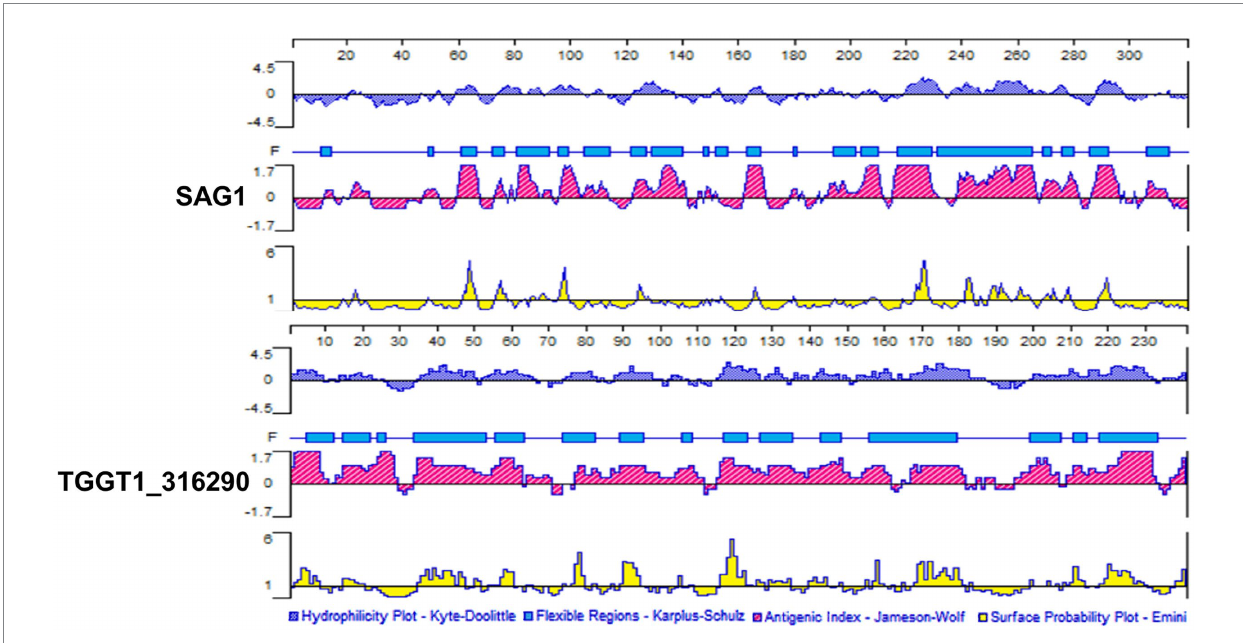
FIGURE 1 Comparison of linear-B cell epitopes of TG290 and SAG1 in terms of DNASTAR predictions of hydrophilicity, flexible regions, antigenic index, and surface probability.